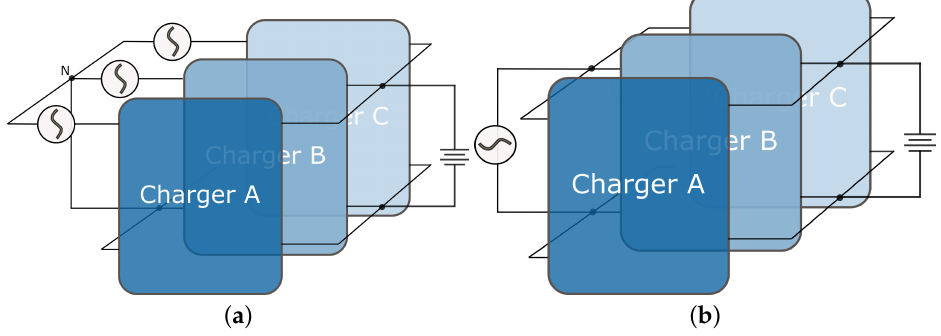
Figure 13. Phase modular charger architecture in a ( a ) three-phase ( b ) single-phase